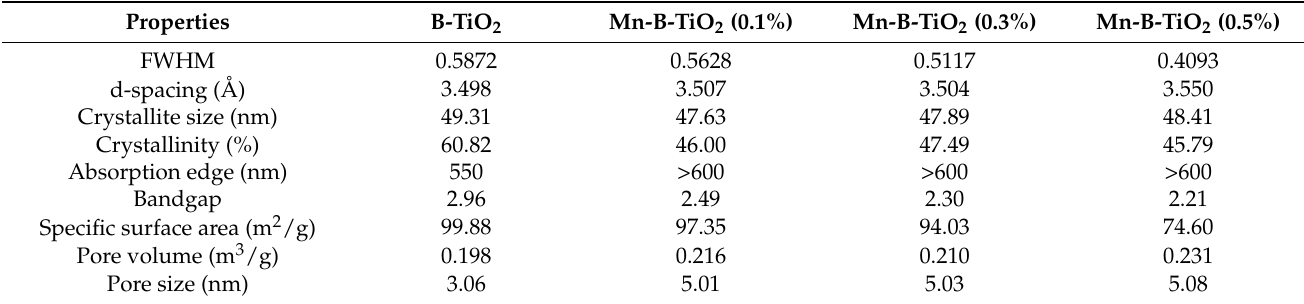
Figure 2. ( a ) XRD patterns, ( b ) DRUV-Vis spectra, and ( c ) Tauc’s plot of the bandgap energies of black and Mn-modified black TiO 2 NPs. Table 1. Summary of the photocatalytic properties of the B-TiO 2 and Mn-B-TiO 2